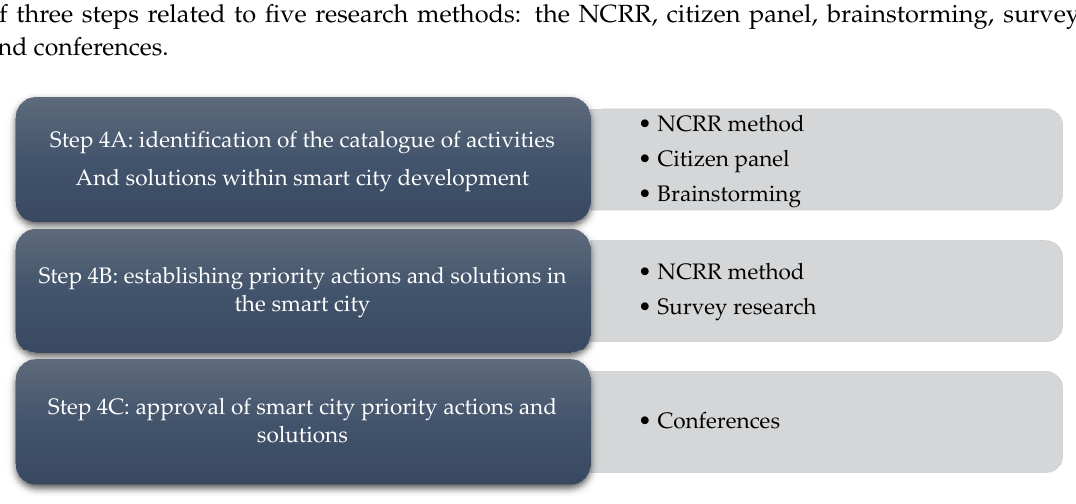
Figure 7. Operationalisation scheme for Stage 4 of the research process.